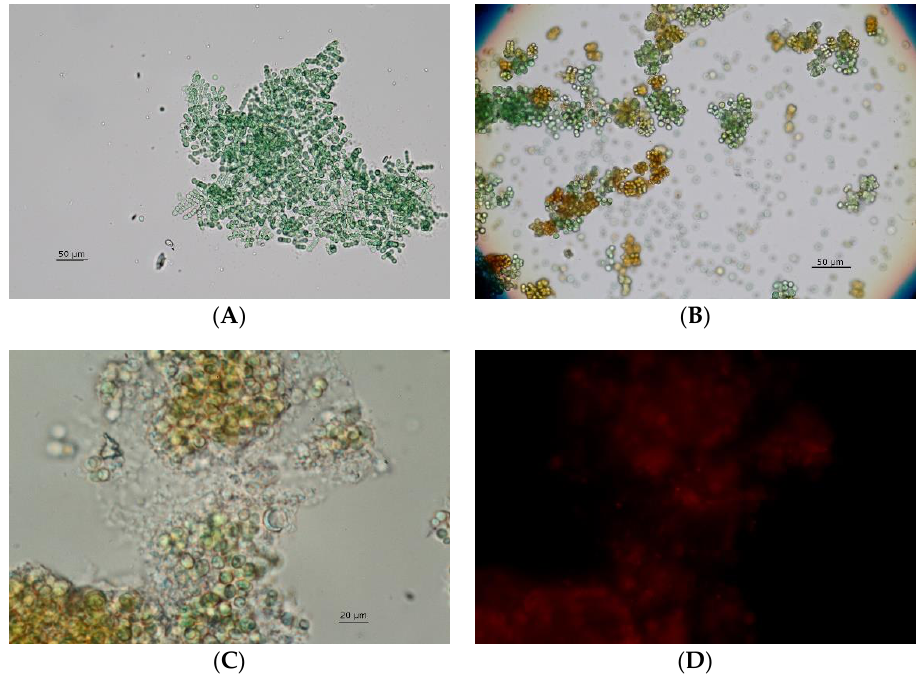
Figure 5. Microscopic imaging of Chlorogloeopsis sp. (Heinrichs-4, AUT) cultures; ( A ) blue-green cells during the growth phase and ( B ) in the stage of nitrogen and phosphorus limitation; ( C ) aged culture in stationary phase in bright field visible light and ( D ) the same section in fluorescence mode after staining with Nile-red.